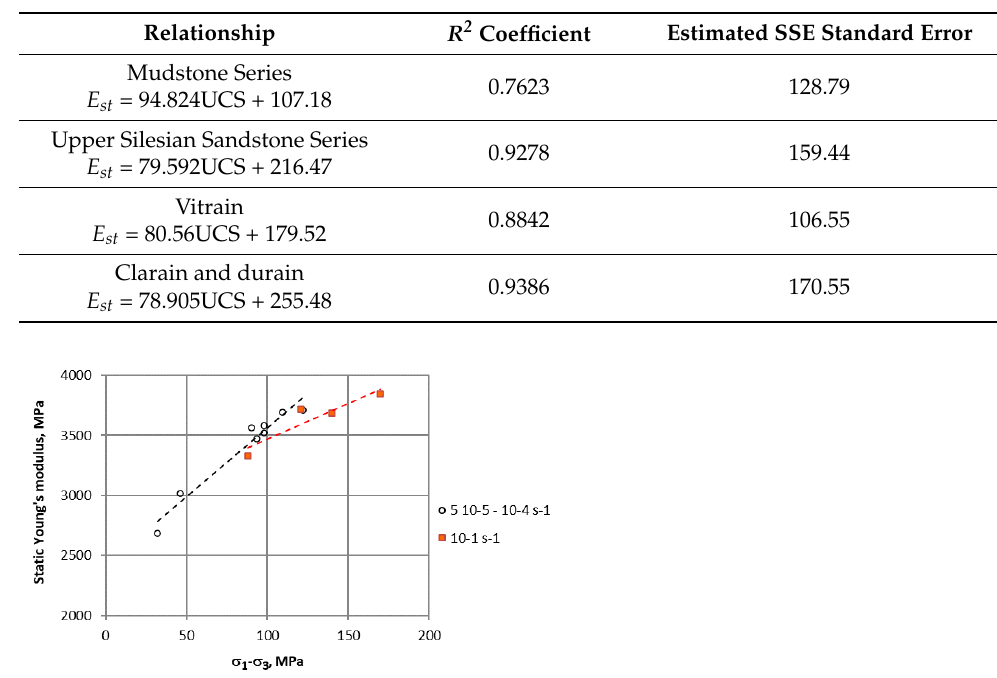
Table 7. Linear regression analysis results of E st = f (UCS) for coals of various geologic age and petrographic structure.